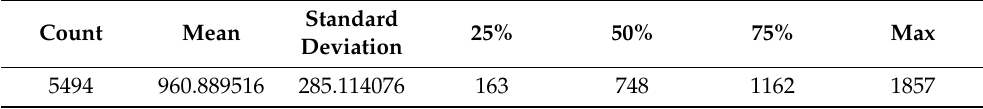
Table 5. Statistical information of the sleep habit score obtained from the logistic regression